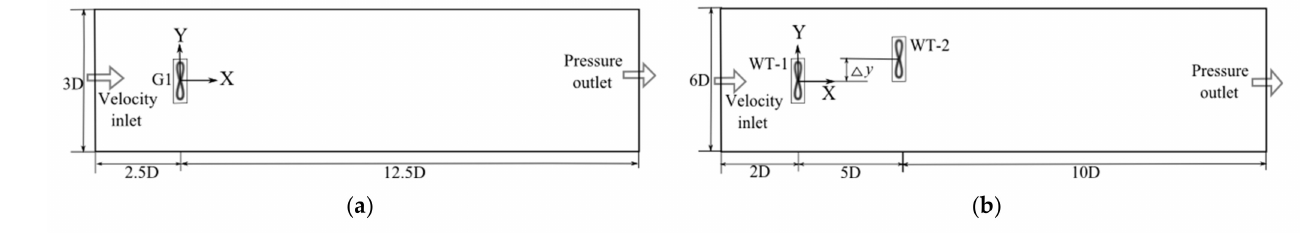
Figure 2. The physical domain used in this study: ( a ) Wind turbine G1; ( b ) NREL 5 MW wind turbines with a staggered arrangement.